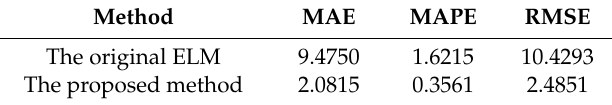
Table 7. Metrics of comparison experiments (Group